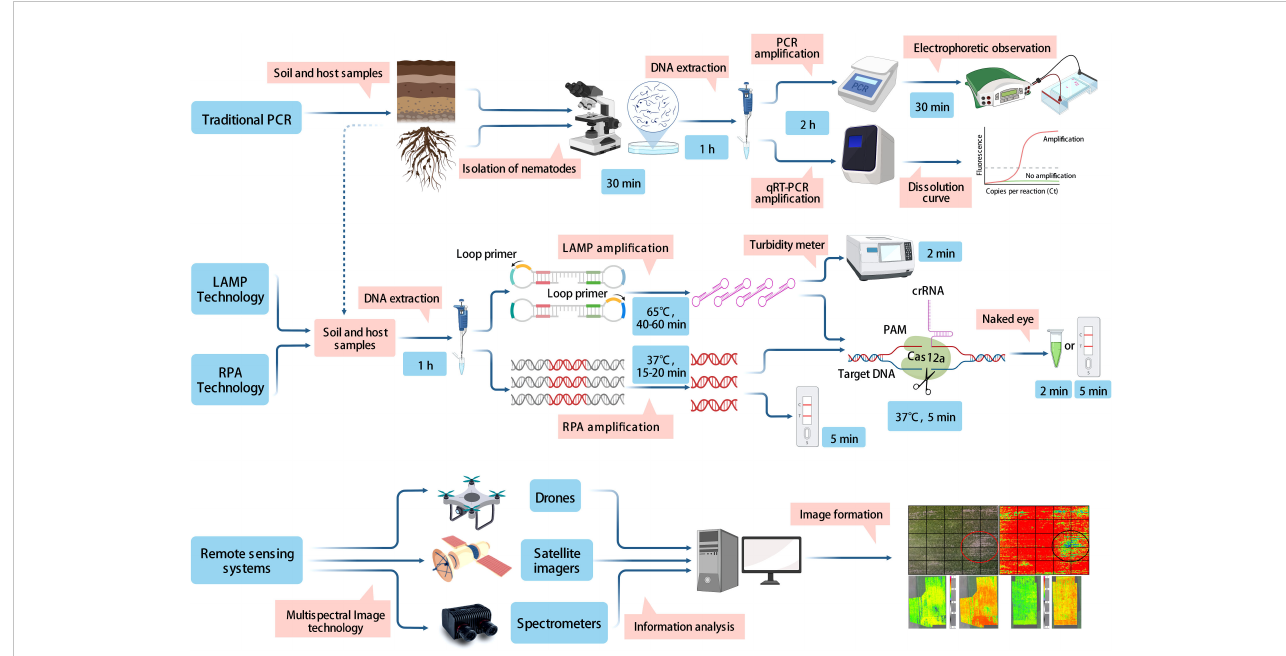
FIGURE 1 Demonstration of the principles and working processes involved in traditional PCR methods, isothermal ampli fi cation techniques, and remote sensing